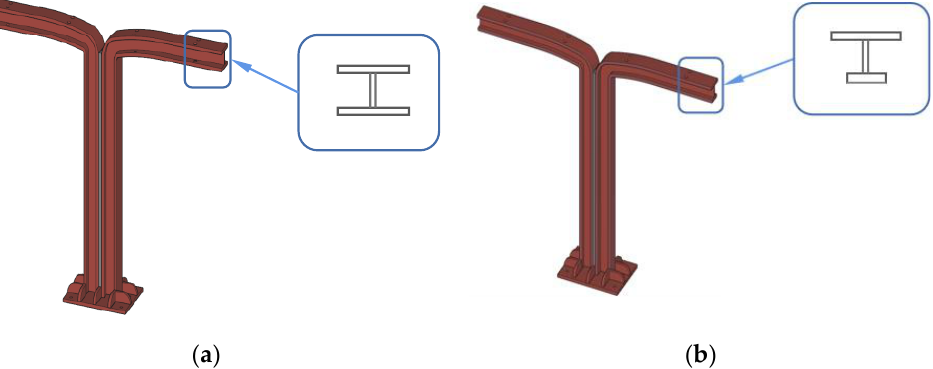
Figure 9 Two new forms of basic unit sections. ( a ) basic unit with a biaxial symmetrical I-section; ( b ) basic unit with a monosymmetrical I-section.